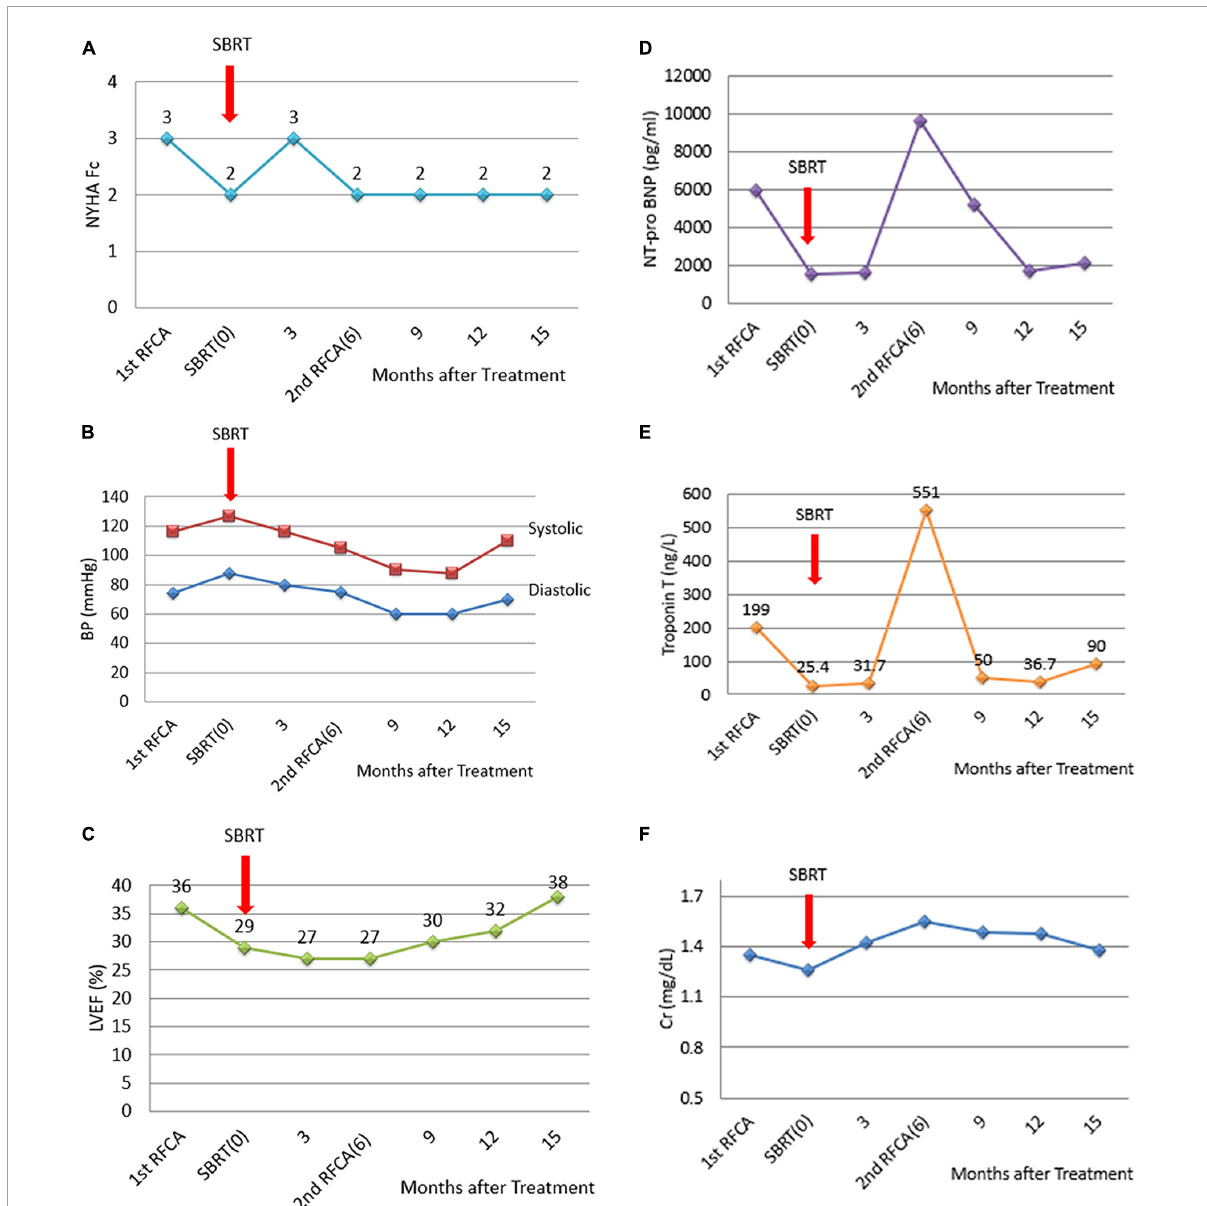
FIGURE5 Diagrams of the NYHA functional classification, blood pressure, LVEF and laboratory data with a timeline for the patient before, during and after the treatment. (A) NYHA functional classification, explaining the severity of heart failure. (B) Blood pressure. (C) LVEF improved slightly after catheter ablation to the RVOT VT. The second electrophysiological study documented successful local treatment with SBRT using 12 Gy at the left ventricular basal to middle posterior septal wall. However, (D) NT-pro-BNP and (E) Troponin T levels increased 6 months after SBRT because of recurrent electric storms derived from the RVOT VT. After catheter ablation of the RVOT VT, serum NT-proBNP and troponin T levels decreased. (F) Serum creatinine levels remained